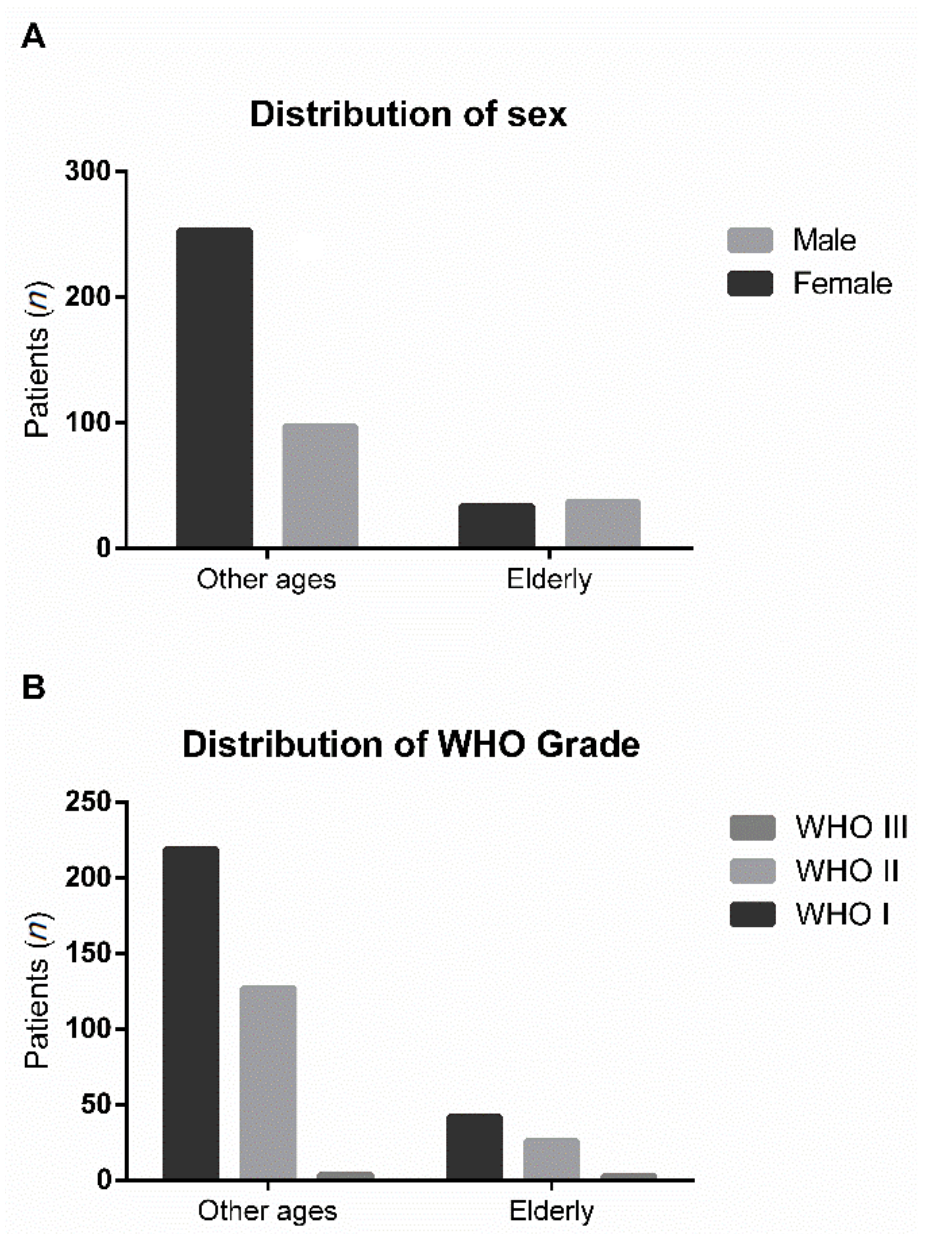
Figure 1. ( A ) Distribution of sex in younger and elderly patients. ( B ) WHO grade distribution in patients of other ages and elderly patients.